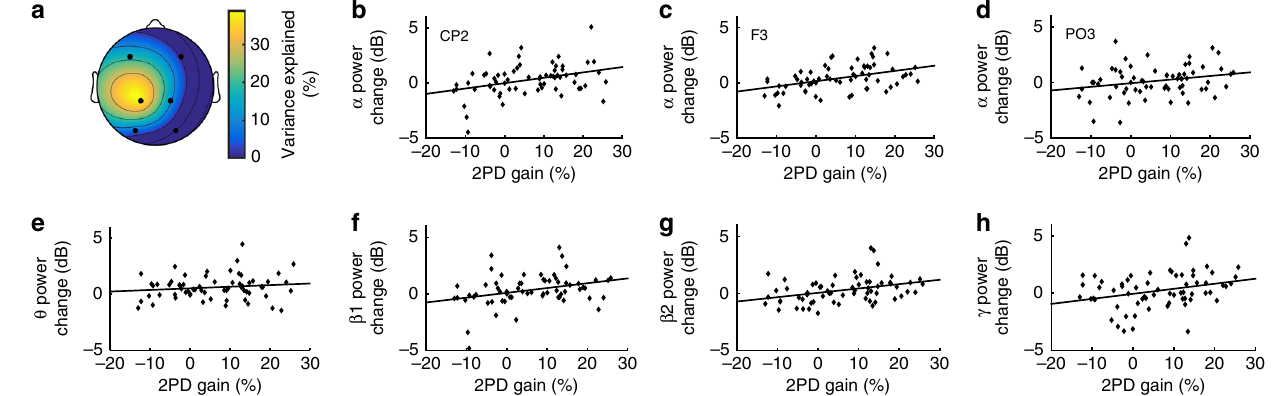
Fig. 4 Variance explained by electrode position and additional frequency bands. a Explained Variance ( R 2 ) of the effect of alpha power on perceptual learning interpolated from the measured electrodes over the scalp is highest over the left somatosensory cortex. b – d The relationships between perceptual learning and alpha power measured over the right somatosensory cortex (CP2; n = 66), over the left frontal hemisphere (F3; n = 66), and over the left occipital hemisphere (PO3; n = 66) were markedly weaker as compared to the left somatosensory cortex (CP1). e Theta oscillations (4 – 7 Hz) had no measurable effect on perceptual learning ( n = 65). Minor effects were observable for lower beta ( f 13 – 20 Hz; n = 65), upper beta ( g , 21 – 30 Hz; n = 67), and lower gamma ( h 31 – 40 Hz; n =